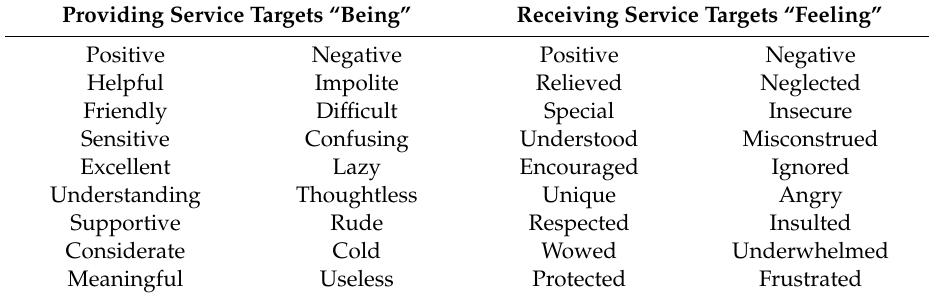
Table 3. Emotional words used to create brief statements used in Test A (Providing) and Test B (Receiving). All target words using in Test A were presented prefixed with the word “being” (e.g., “being helpful”, “being friendly”), whereas those used for Test B were pre-fixed with the word “feeling” (e.g., “feeling relieved”, “feeling